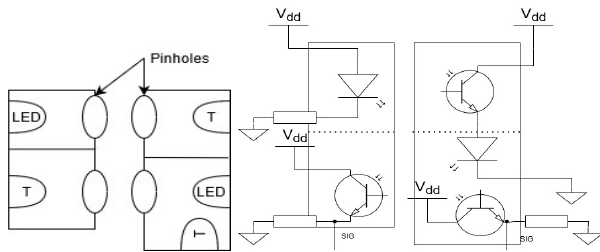
Fig. 2. The calibration platform (left) and architecture of it (right). Both encoders use an ABI interface. Stator encoder is attached to the motor controller, which tracks encoder data. Rotor encoder is attached to the Arduino, which substitutes the motor controller for the rotor encoder. Encoder data are then read via the UART bus by the respective RPI microcomputers. Encoders are set to 2048 pulses per rotation or PPR which translate to 8192 counts per rotation or CPR (on the motor axis). Since a 10:1 reduction is used, for each rotation of the platform, 81 920 encoder counts are obtained. To get the same CPR for both encoders, a 1:10 reduction is used between a static gear and the encoder gear on the platform.